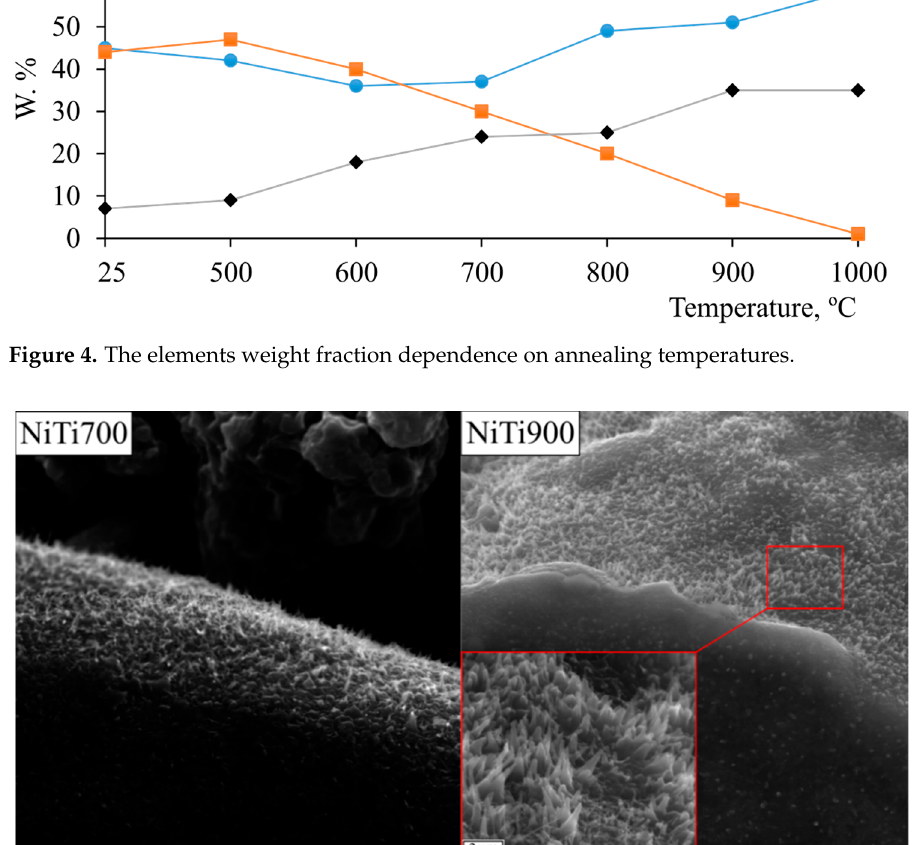
Figure 4. The elements weight fraction dependence on annealing temperatures.